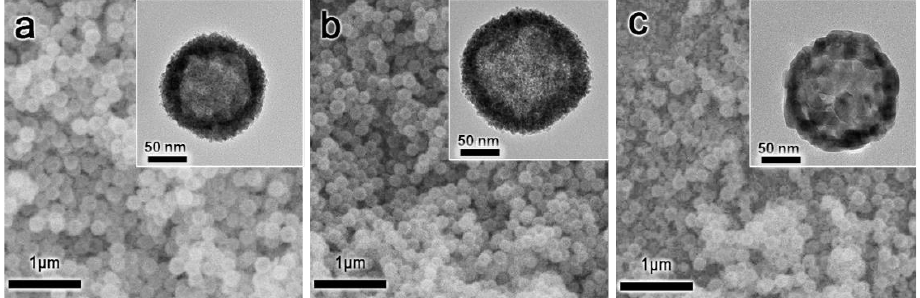
Figure 1. SEM and TEM (inset) images of the H-CeO 2 samples: ( a ) H-CeO 2 (HT), ( b ) H-CeO 2 (500), and ( c ) H-CeO 2 (800).